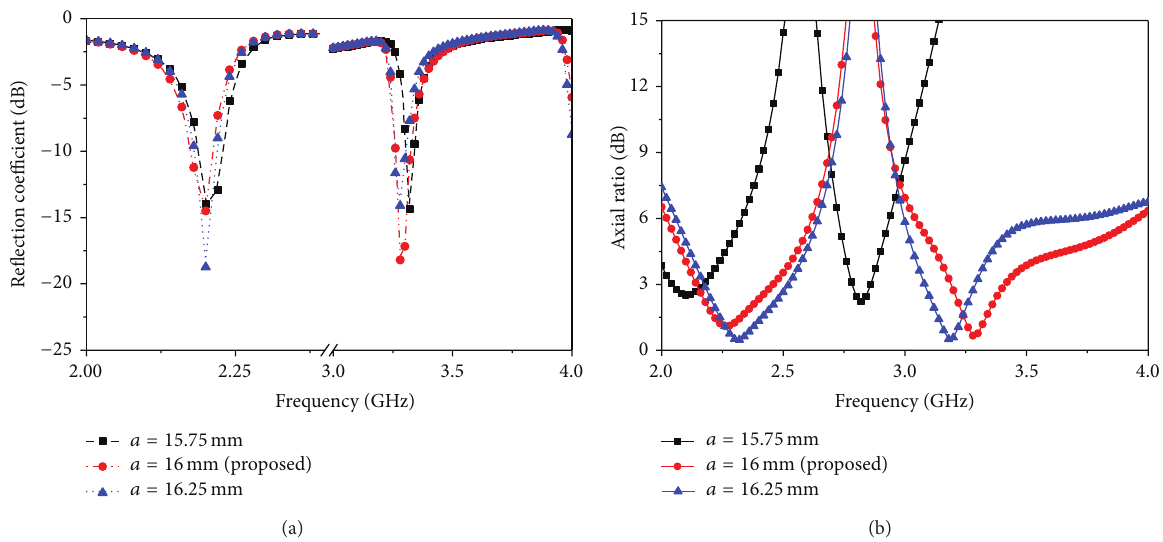
Figure 5: Different length reflection coefficient and axial ratio results for the cross-shaped slot antenna. (a) Reflection coefficient and (b) axial ratio.